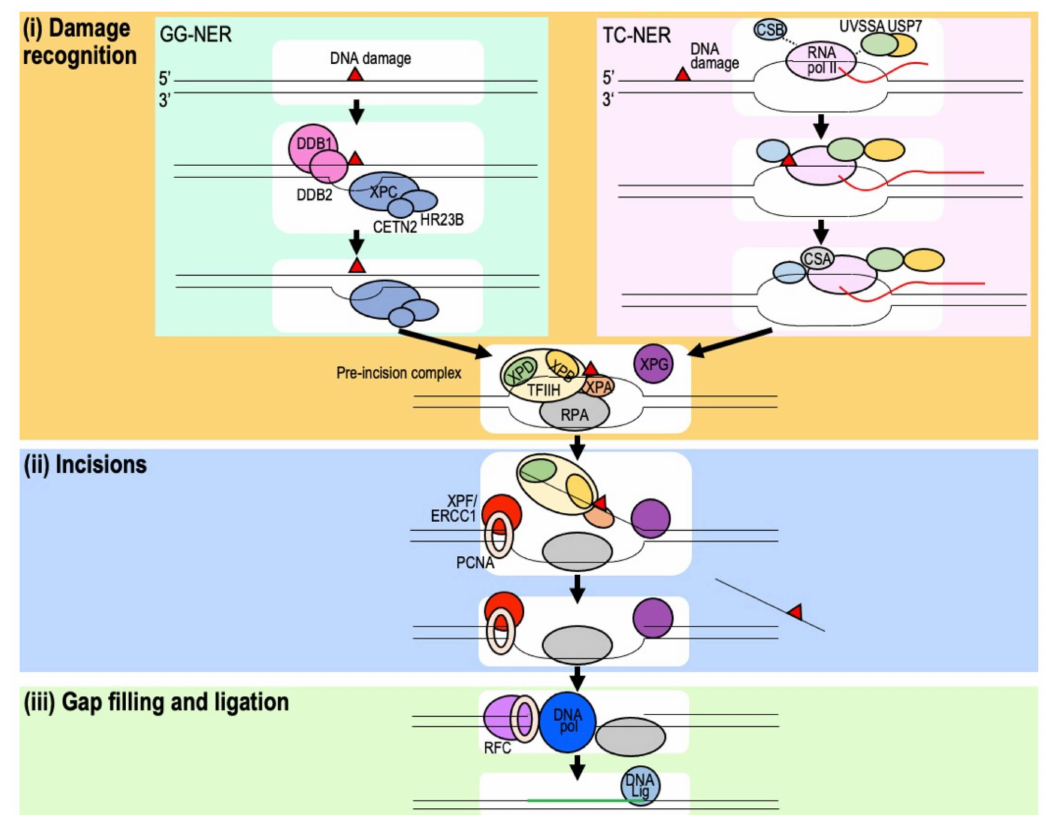
Figure 3. The NER pathway. ( i ) DNA damage can be recognized by XPC/HR23B/CETN2 and/or DDB1/2, which detect helix distortions caused by lesions during GG-NER, or indirectly upon RNA pol II stalling at a DNA lesion during TC-NER. Stalled RNA pol II tightly binds CSB complexed with CSA and UVSSA/USP7. After damage recognition, the TFIIH complex, which includes the helicases XPD and XPB as subunits, is recruited to the site of damage, and TFIIH further recruits XPA and verifies the existence of the damage. RPA binds to ssDNA, and endonuclease XPG is recruited to the complex by TFIIH, forming the TFIIH-XPA-RPA-XPG pre-incision complex. ( ii ) The endonuclease XPF-ERCC1 complex recruited by XPA incises 5 (cid:48) to the lesion. Subsequent incision by XPG occurs, releasing the oligonucleotide containing the damage. ( iii ) The gap is filled and ligated. Green line: newly synthesized